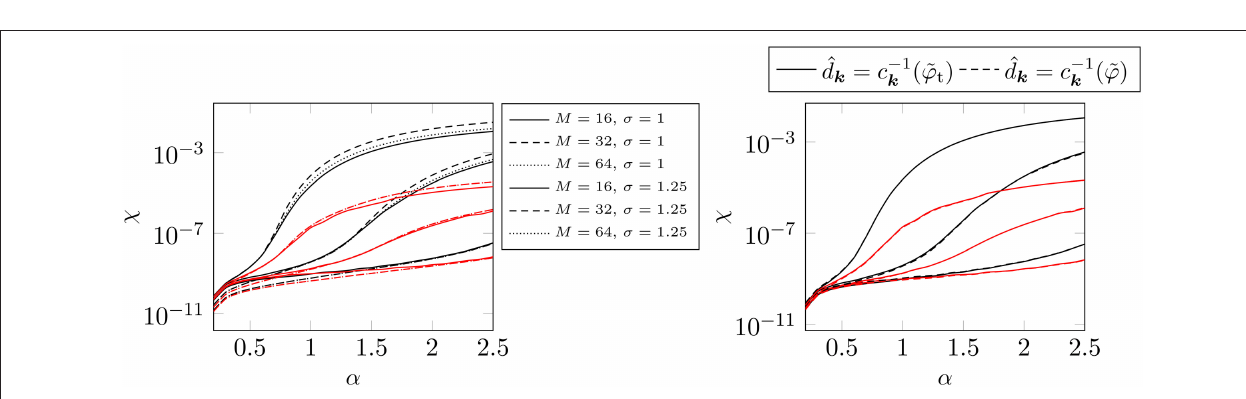
FIGURE 6 | LHS: Approximate values for χ opt via Equation (46) (dotted) and χ std via Equation (45) (dashed) for different far field cutoffs M with respect to the splitting parameter α . Thereby we choose the support parameter m errors ( χ std ) are represented by the solid lines. RHS : We compare the results obtained by setting ˆ d k function: